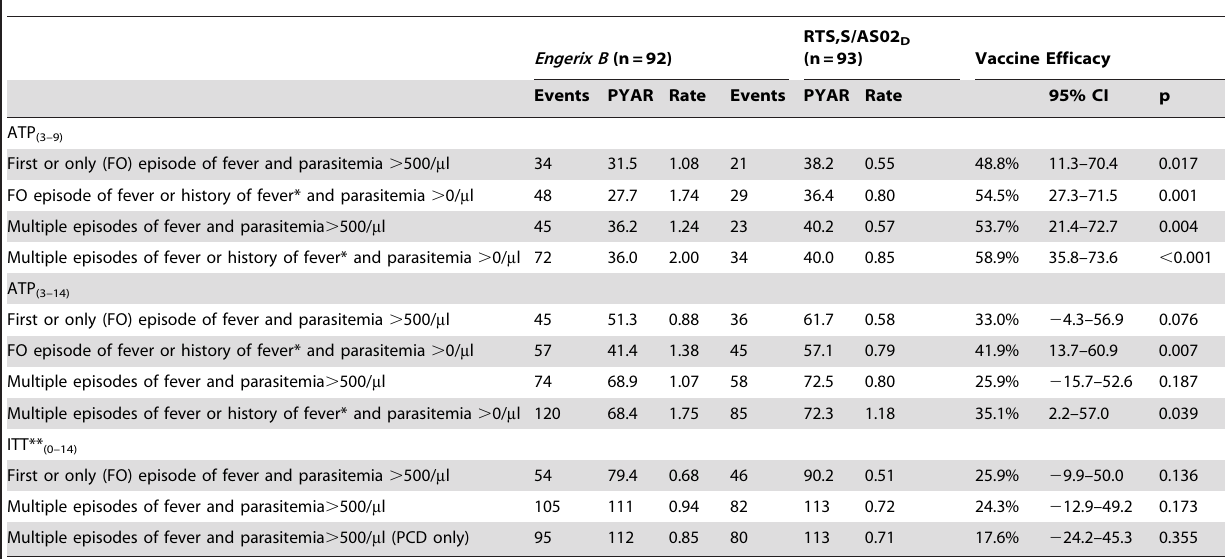
Table 4. Vaccine efficacy evaluated for different follow-up periods.